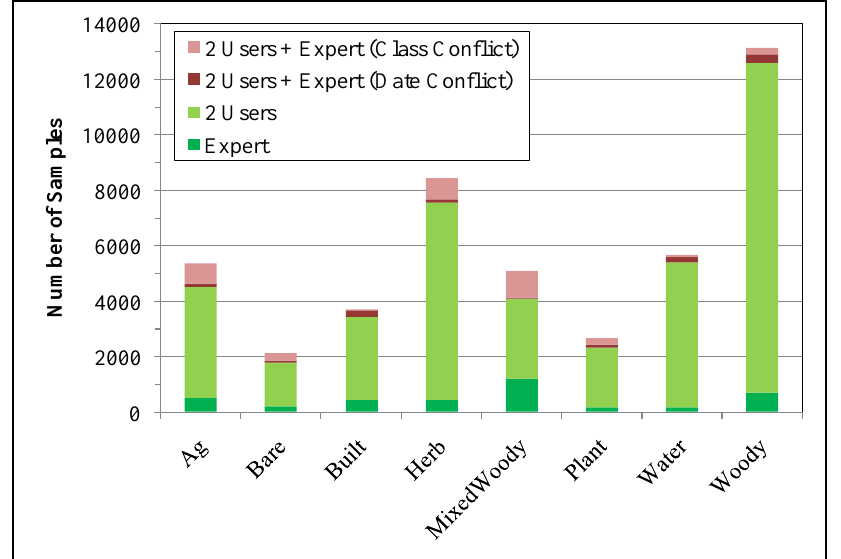
Figure 7. Class distribution of all samples collected from Latin America and the